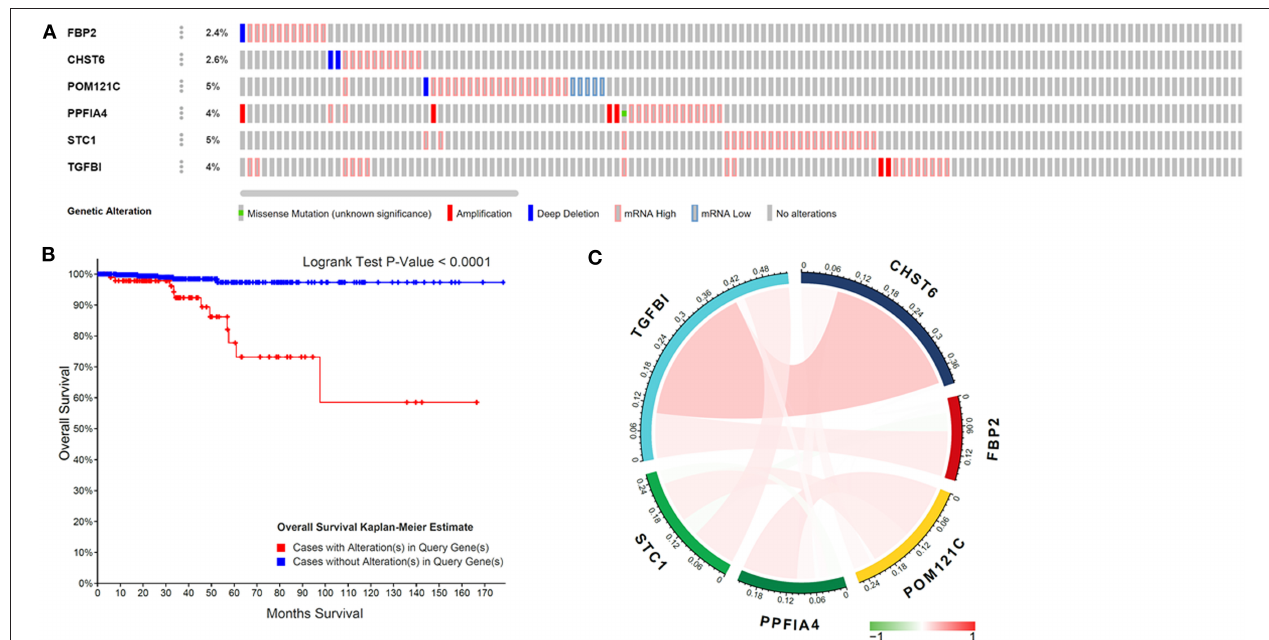
FIGURE 3 | Glycolysis-related gene mutations and the correlation with gene expression in THCA patients. (A) Mutations of six genes in patients with THCA. (B) Kaplan–Meier survival curve for THCA patients stratified by the six-gene mutations. (C) Pearson correlation of six genes.